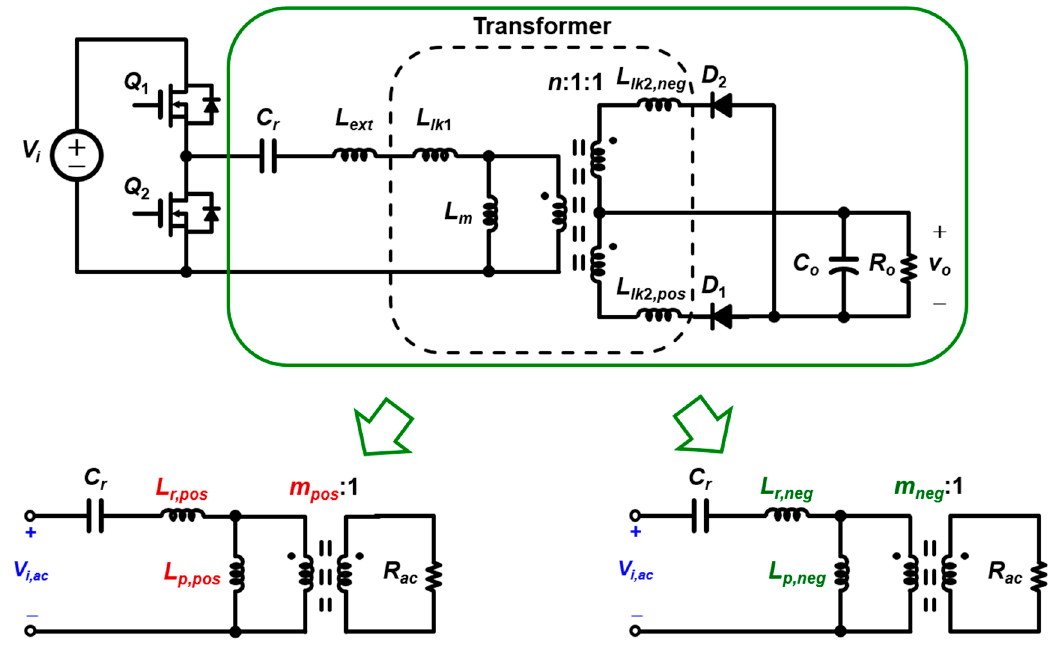
Figure 4. Different equivalent circuit models of the transformer ( a ) T model and ( b ) L model.